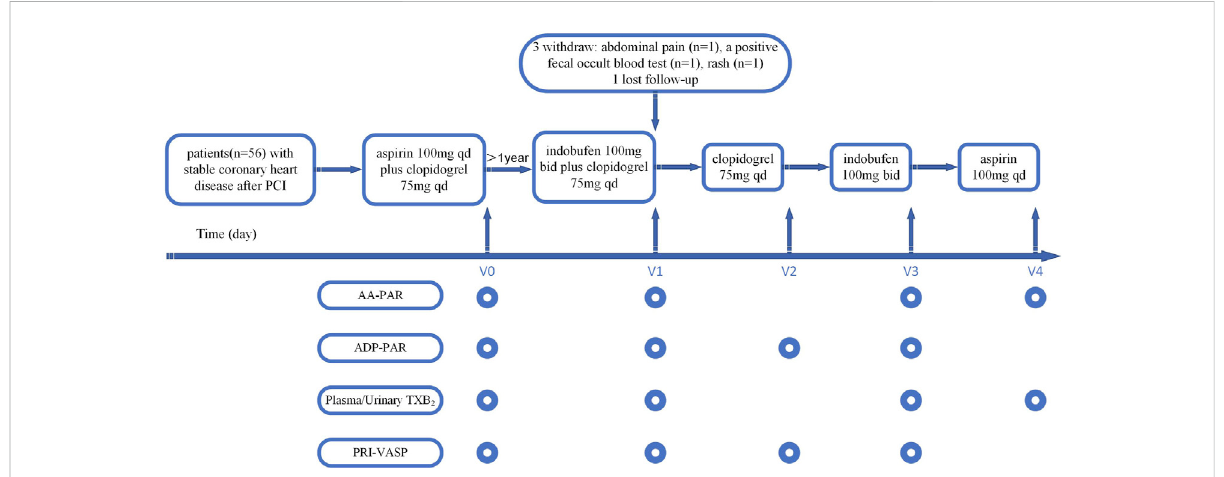
FIGURE 1 Study fl ow chart. AA-PAR = rate of arachidonic acid-induced platelet aggregation measured by light transmission aggregometry; ADP-PAR = rate of adenosine diphosphate-induced platelet aggregation measured by light transmission aggregometry; bid = twice daily; PCI = percutaneous coronary intervention; PRI-VASP = platelet reactivity index measured by vasodilator-stimulated phosphoprotein; qd = once daily; TXB 2 = thromboxane B 2 ; V0 = visit at baseline; V1 = visit at the fi rst month; V2 = visit at the second month; V3 = visit at the third month; V4 = visit at the fourth